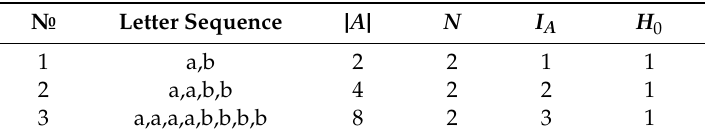
Table 2. Information characteristics of letter sequences having di ff erent lengths and the same variety of letters.